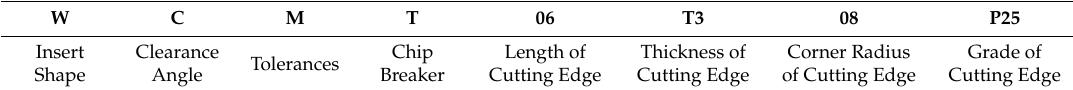
Table 2. Cutting tool nomenclature.